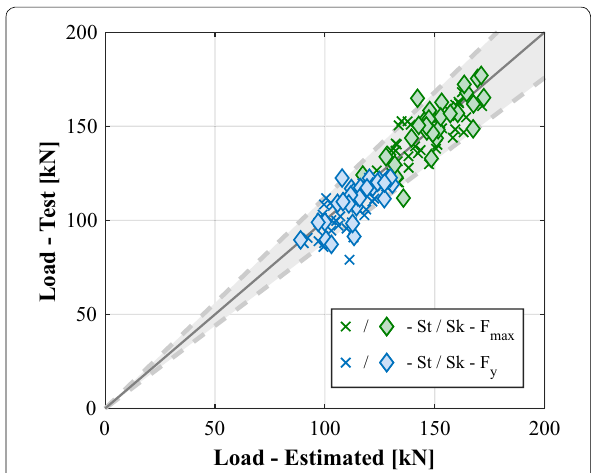
Fig. 11 Comparison between Load measured at test and Load estimated through μ ccs by Eq. 1.